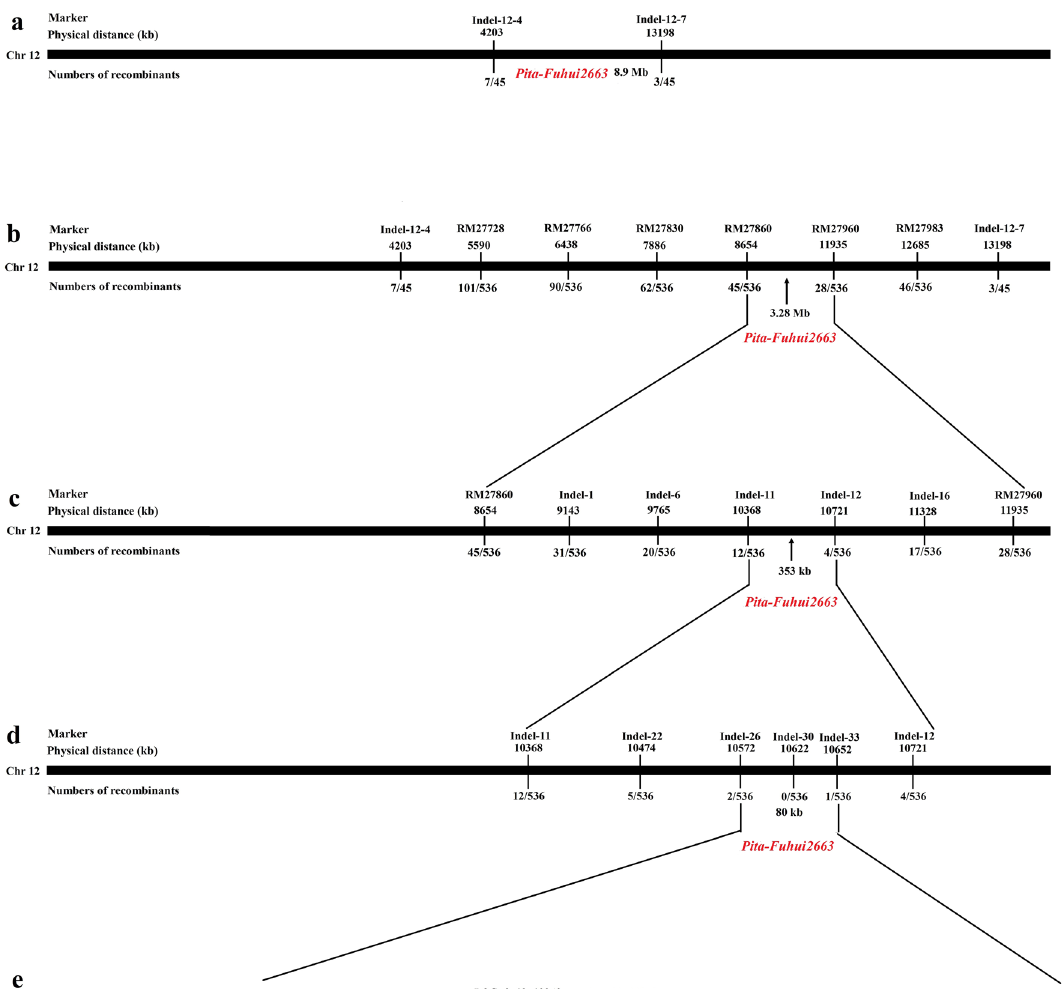
Figure 2. Genetic and physical maps of the Pita-Fuhui2663 gene. ( a ) Primary mapping of the resistance gene; the Pita-Fuhui2663 gene was identified between markers Indel-12-4 and Indel-12-7. ( b ) Further mapping of the resistance gene; the Pita-Fuhui2663 gene was identified between markers RM27860 and RM27960. ( c ) Fine mapping of the resistance gene; the Pita-Fuhui2663 gene was identified between markers Indel-11 and Indel- 12. ( d ) High-resolution mapping of the resistance gene; the Pita-Fuhui2663 gene was eventually mapped to an 80-kb region between markers Indel-26 and Indel-33, and the number of recombinations between the marker and the target gene is shown on the linkage map. ( e ) There were eight annotated genes in the 80-kb region.